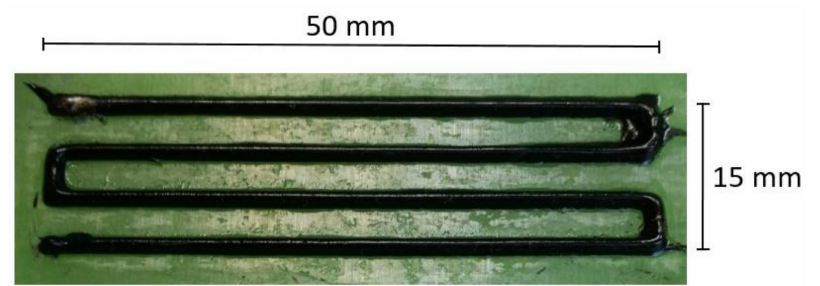
Figure 2. 3D printed